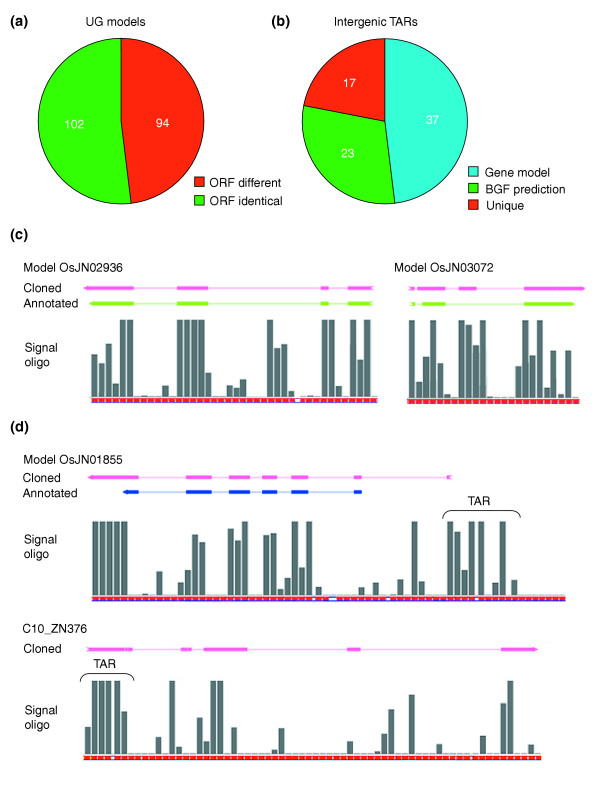
Cloning and sequence analysis of japonica chromosome 10 UG models and intergenic TARs. (a) Summary of RT-PCR analysis of selected UG models. ORF identical, annotated ORF is the same as determined from the cloned sequence; ORF different, annotated ORF is different from that in the cloned sequence. (b) Summary of RT-PCR analysis of selected intergenic TARs. Gene model, cloned TARs overlapping with TIGR models; BGF prediction, cloned TARs overlapping with BGF predictions; unique, cloned TARs not overlapping with any annotated feature. (c) Representative UG models whose cloned sequences either differ from (OsJN02936) or are the same as (OsJN03072) the annotated ones. (d) Representative intergenic TARs whose cloned sequences either overlap with a TIGR model (OsJN01855) or are completely intergenic (C10_ZN376). Representation of microarray data in this figure is the same as in Figure 2 except that the oligo index is omitted.